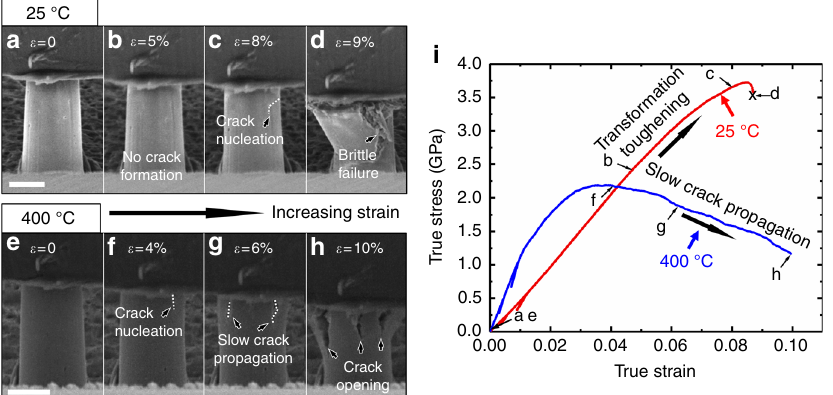
Fig. 2 Uniaxial in situ microcompression tests on the fl ash-sintered 3YSZ at room temperature and 400 °C at a constant strain rate of 5 × 10 − 3 s − 1 . a – d SEM images during in situ compression test of a micropillar at different strain levels at 25 °C. No crack can be detected until a true strain of 8%. At the strain of ~9%, the pillar experienced brittle catastrophic fracture. Scale bar, 2 μ m. e – h For micropillars tested at 400 °C, cracks nucleated at smaller strain, ~4%. Crack density increased with compressive strain. However, cracks propagated downward gradually and slowly without catastrophic failure. Scale bar, 2 μ m. i The corresponding true stress – strain curve shows that the fl ow stress exceeds 3.5 GPa for pillars tested at 25 °C. In comparison, the pillar tested at 400 °C has a fl ow stress of 2 GPa and higher elastic modulus determined from partial loading and unloading experiments